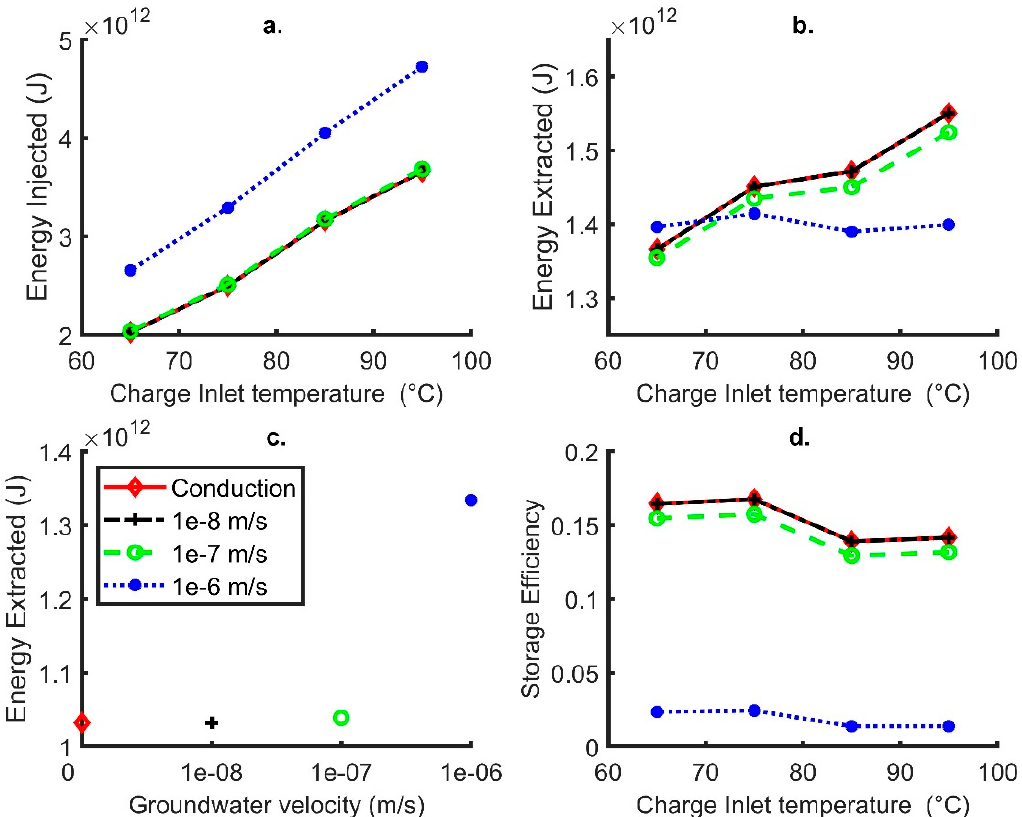
Figure 8. The impact of varying the constant DBHE input temperature during a 6 month heat charge cycle, followed by a 6 month discharge cycle. DBHE internal flow rate = 5 L/s and discharge inlet temperature was maintained constant at 5 °C. ( a ) energy injected during charge, ( b ) energy extracted during discharge cycle following charge, ( c ) energy extracted during a 6 month discharge period without preceding charge and ( d ) storage efficiency calculated according to Equation (10).